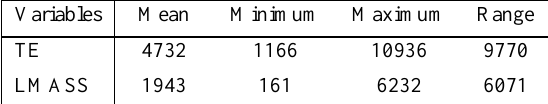
Table 2. Descriptive statistics for TE and LMASS